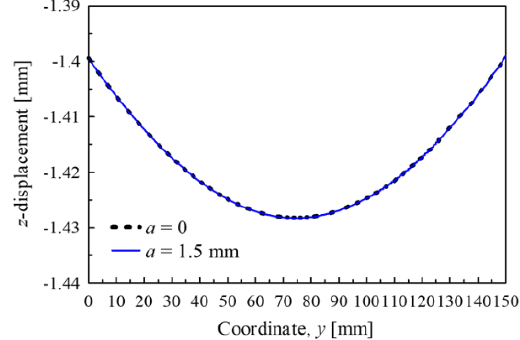
Figure 16. The z -displacement of the surface of Model 3D along trace line 2. The z -displacement implies the change in z -direction due to loading.